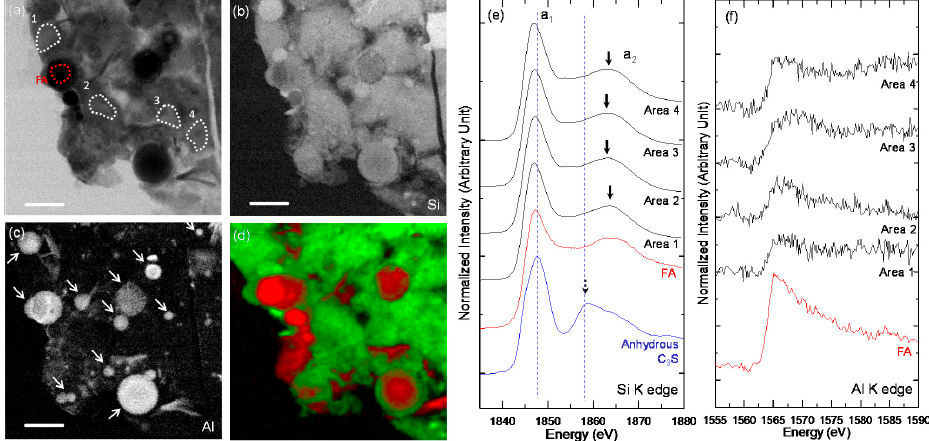
Figure 8. The STXM results of C-FA-28d (Figure 7c-1). ( a ) Single image taken at 1840 eV with marked areas selected for Si NEXAFS analysis (FA: fly ash); ( b ) Si image contrast map; ( c ) Al image contrast map; ( d ) RGB overlay maps obtained using the spectra obtained from FA ( red ) and Area 2 ( green ); ( e ) Si K edge NEXAFS spectra, and ( f ) Al K edge NEXAFS spectra. The Si and Al K edge spectra were obtained from ROIs illustrated in ( a ). Fly ash particles are indicated by the arrows in the Al image contrast map.